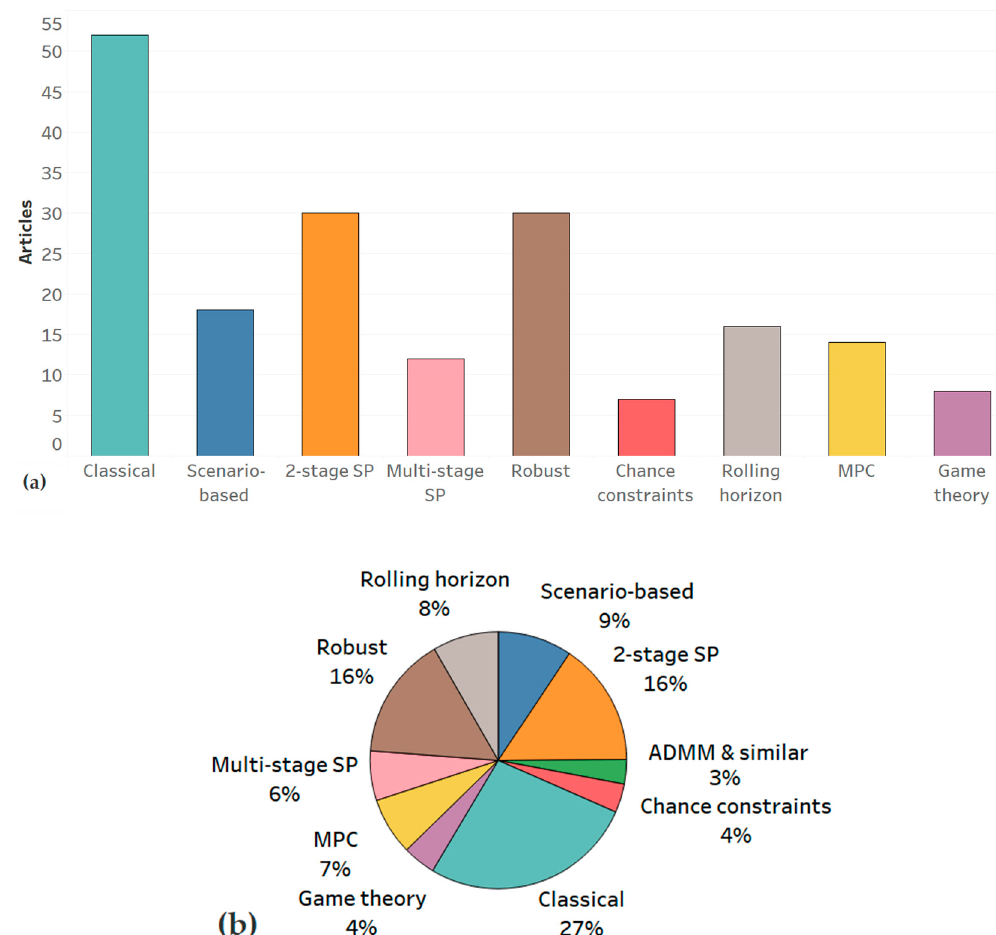
Figure 9. ( a ) Number of articles that use a particular problem formulation. ( b ) Share of each problem formulation in the total number of formulations in the pool of articles. Note: an article may have a formulation that belongs to more than one category.